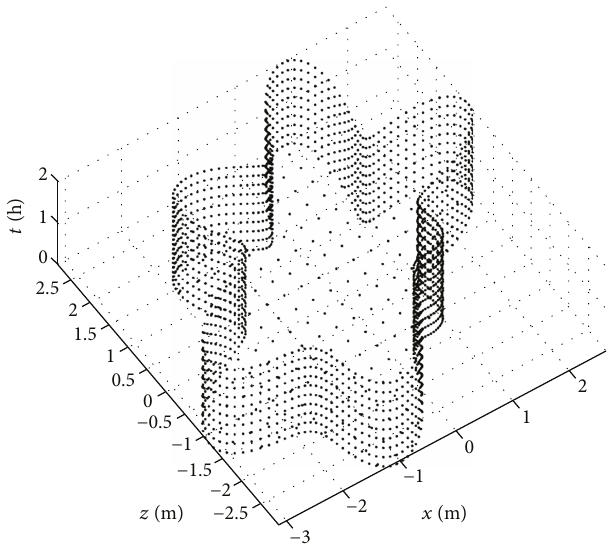
Figure 9: Spacetime boundary collocation points of the two-dimensional transient fl ow in unsaturated